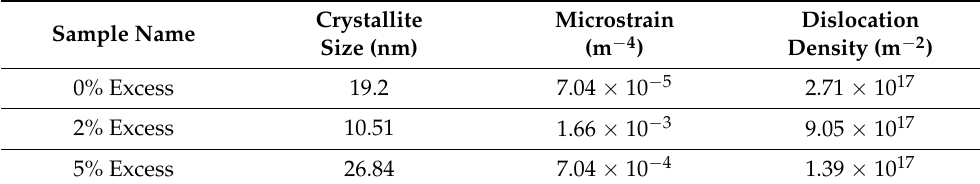
Table 2. XRD parameters of BiFeO 3